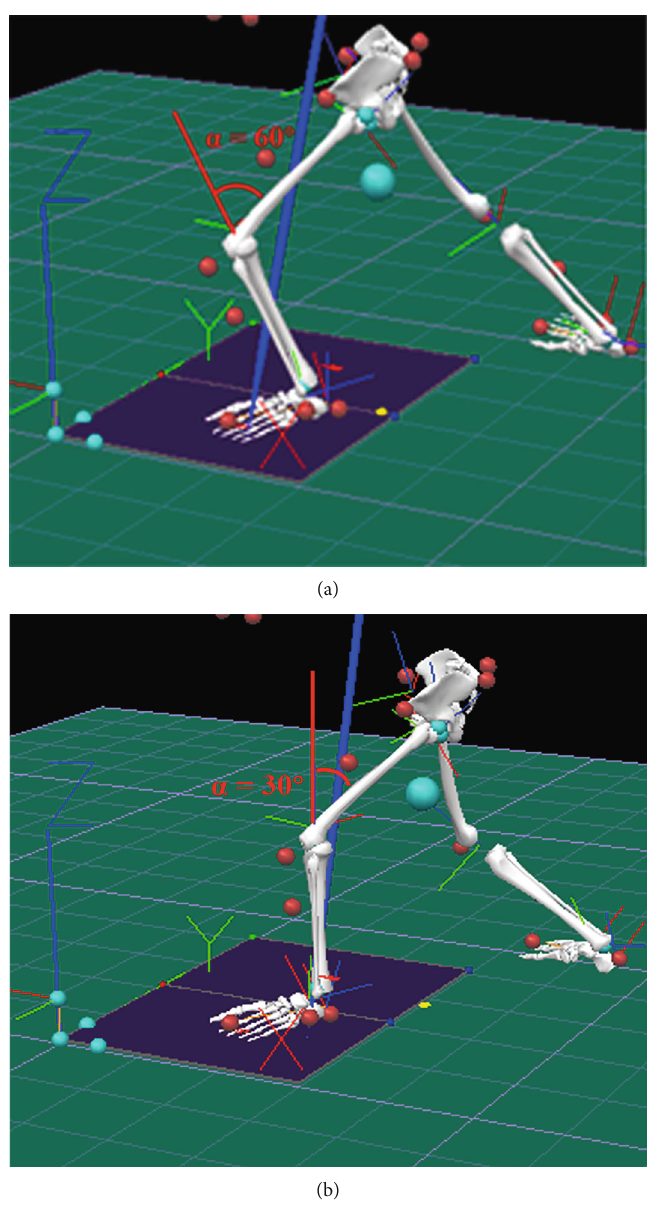
Figure 2: Peak knee fl exion angle (left knee): (a) α = 60 ± 5 ° for low pose. (b) α = 30 ± 5 ° for high